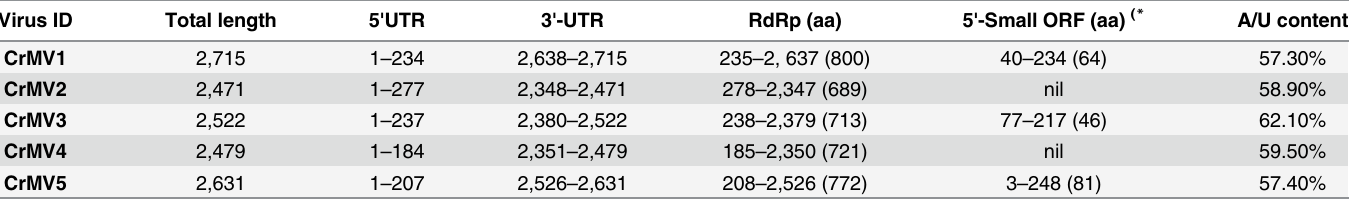
Table 2. Sequence characterization of Cronartium ribicola mitoviruses (CriMV) based on Sanger sequencing of cDNA clones. Virus ID Total